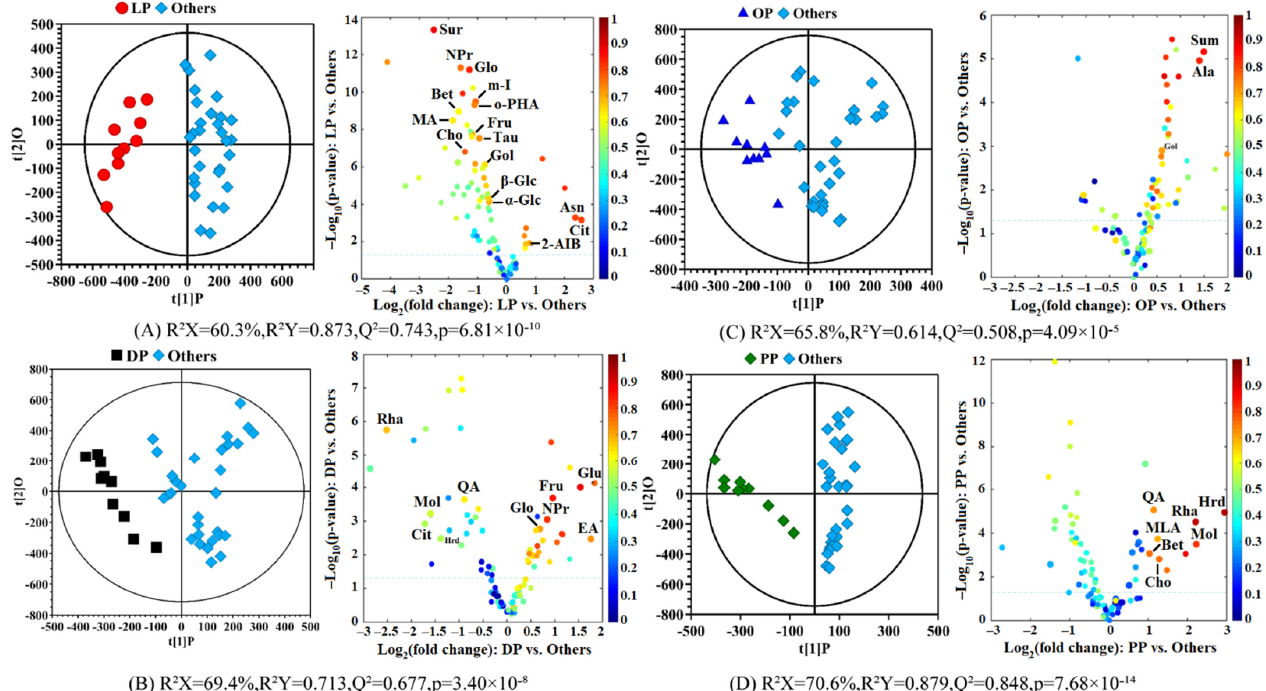
Figure 4. OPLS-DA score plots (left panels) and the corresponding volcano plots (right panels) derived from the NMR data of citrus pericarps in the different varieties. ( A ) Lemon pericarp vs. other pericarps; ( B ) Dekopon pericarp vs. other pericarps; ( C ) Sweet orange pericarp vs. other pericarps; ( D ) Pomelo pericarp vs. other pericarps. LP: lemon pericarp; DP: dekopon pericarp; OP: sweet orange pericarp; PP: pomelo pericarp; Others: other three varieties of citrus pericarps. The marked dots in the volcano plots represent the components with statistically significant differences between the pair-wise groups. The keys of the components were shown in Table 1.